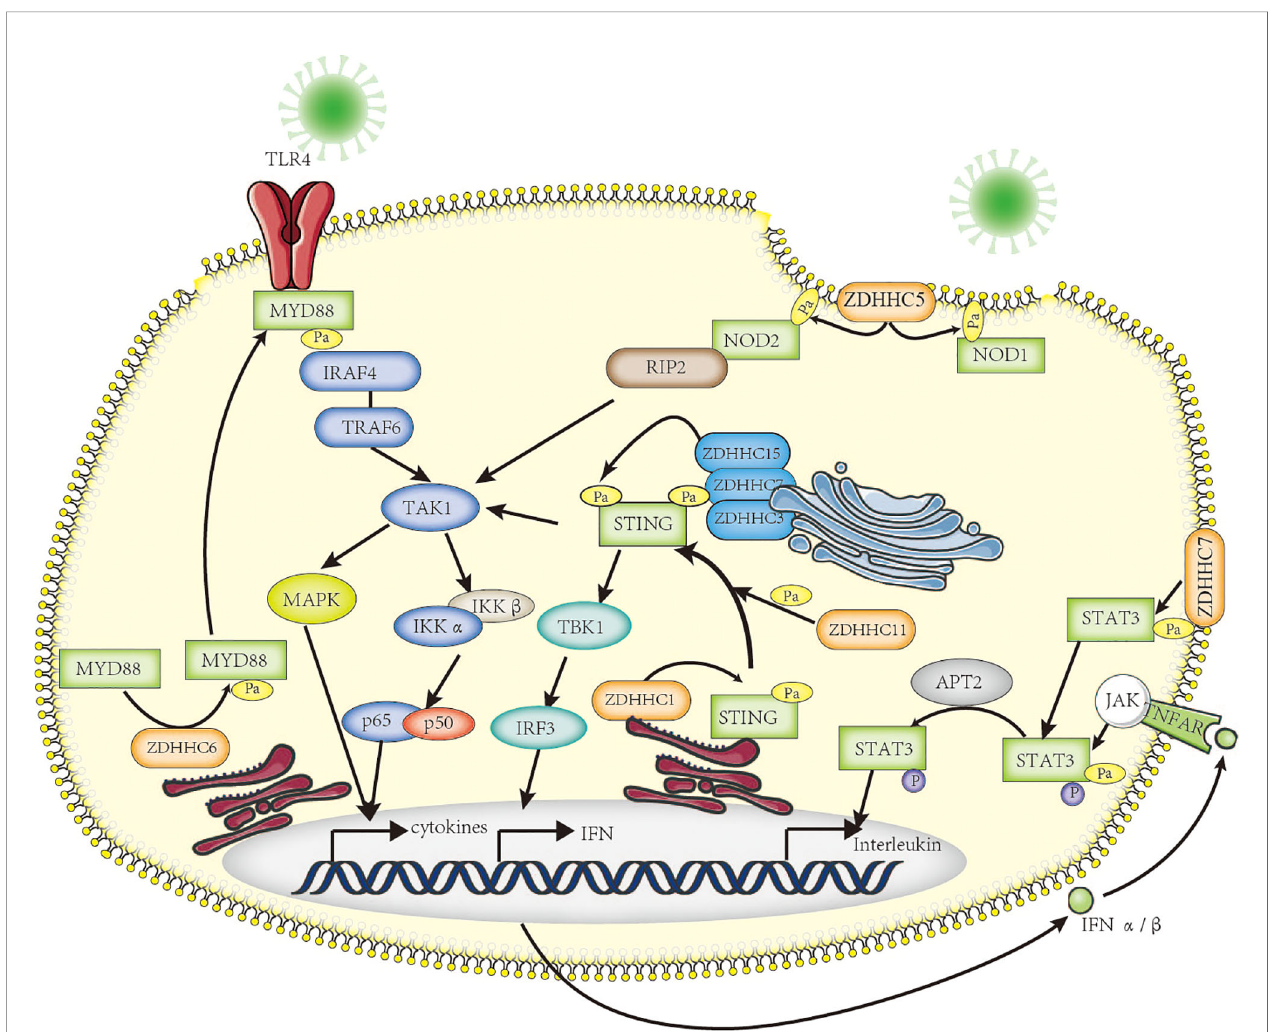
FIGURE 2 | The roles of palmitoylation in in fl ammation. Palmitoylation affects in fl ammatory response in many ways. MYD88 is palmitoylated by ZDHHC6, facilitating downstream NF- k B in fl ammation pathway activation by mediating association with IRAF-4. NOD1/2 is palmitoylated by ZDHHC5, which is required for membrane recruitment and downstream signaling. Five palmitoyl-transferases (localized at different cell compartments including ER and Golgi apparatus) positively regulate STING-dependent in fl ammatory response. The STAT3 palmitoylation – depalmitoylation cycle, catalyzed by DHHC7 and APT2, controls phosphorylation of STAT3 by JAK2 and contributes to STAT3 nuclear translocation, which is essential for IL-17 – induced in fl